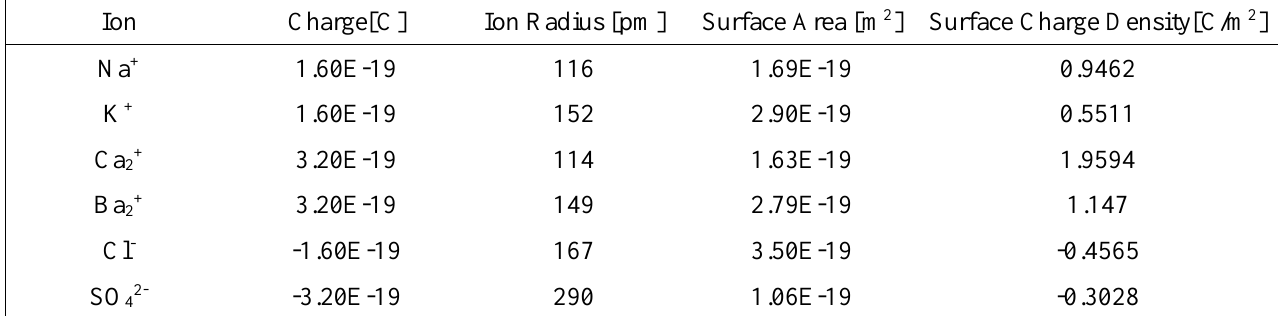
Table 1—The surface charge density of the focus ions (Essington 2005).